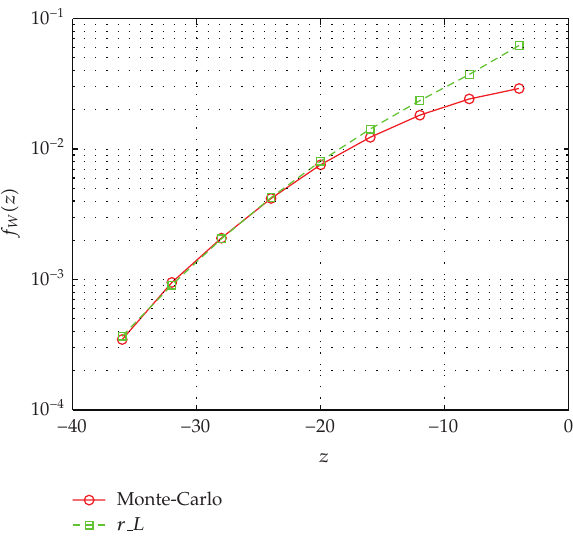
Figure 6: Left tail f W , (cid:5) σ x ,σ y (cid:6) (cid:8) (cid:5) 12 , 9 . 6 (cid:6) . r L is the